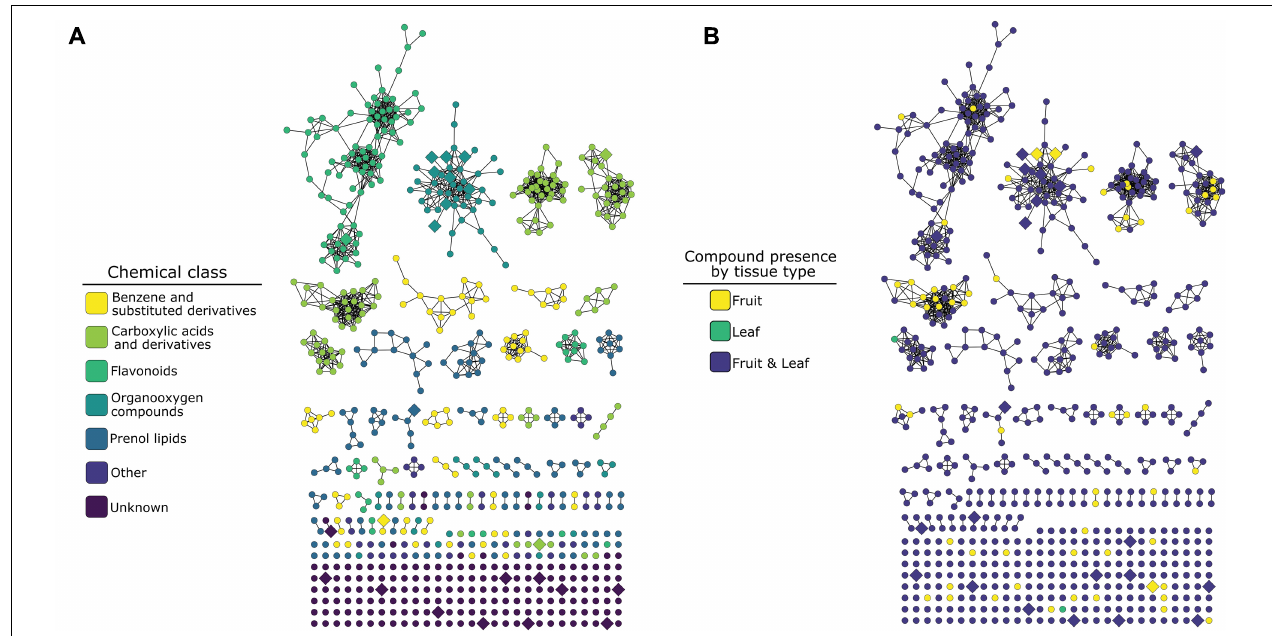
FIGURE 2 | Molecular network of 706 compounds from 12 Piper species color-coded by ClassyFire chemical classification annotation (A) or by organ-specific occurrence across the 12 species (B) . Nodes represent compounds, and edges represent the structural similarity between different compounds (see section “Molecular Networking” methods for detail). Enlarged, diamond-shaped nodes represent compounds identified by the Boruta analysis as important for distinguishing among organs. In (B) , compounds are coded as occurring in “fruit” if they occur in one or more of the three sample types (unripe pulp, ripe pulp, or